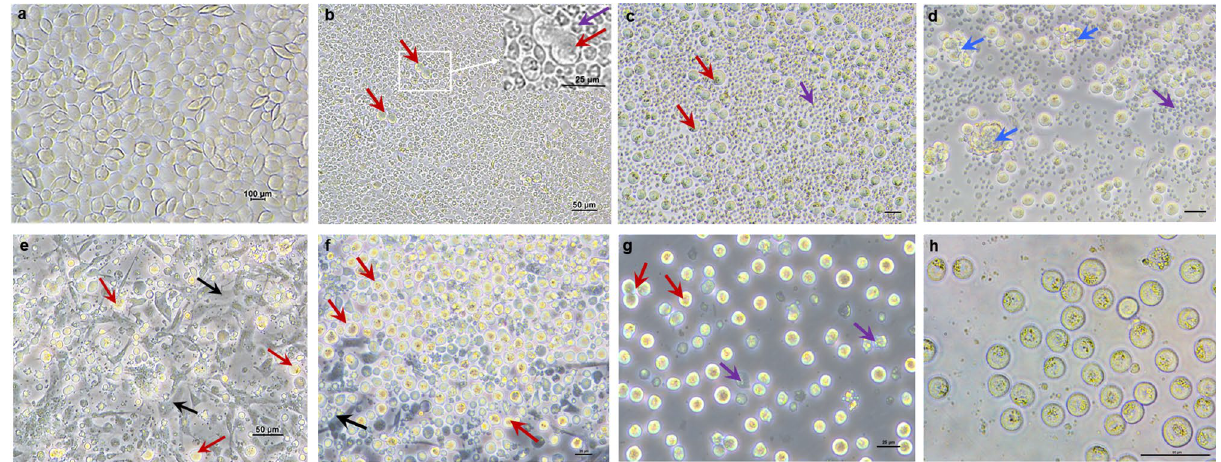
Figure 1. Establishment of PGC lines from embryonic blood and gonads. ( a ) At day 1 of in vitro culture of embryonic blood. Haemopoietic precursor cells dominate the culture (scale bar: 10 µm). ( b ) At day 4 of in vitro culture of embryonic blood, two dividing PGCs (Doublets) are visible (scale bar: 50 µm). ( c ) At day 9 of in vitro culture of blood-derived PGCs which now dominate the cell culture (scale bar: 25 µm). ( d ) At day 13 of in vitro culture of a female blood-derived PGC-lineage which tends to form cluster (scale bar: 25 µm). ( e ) At day 1 of in vitro culture of gonadal-derived PGCs. PGCs are loosely attached to the surface of the gonadal stroma cells (scale bar: 50 µm). ( f ) At day 3 of in vitro culture of gonadal-derived and already proliferated PGCs (scale bar: 25 µm). ( g ) At day 10 of in vitro culture of gonadal-derived PGCs. Subculturing eliminates the adherent stroma cells but some cell debris is still present (scale bar: 25 µm). ( h ) Established male PGC-lineage with lipid vacuoles in the cytoplasm (as described here: 8 ) (scale bar: 50 µm). red arrows: PGC, black arrows: gonadal stroma cell, blue arrows: cell cluster, violet arrows: cell debris.